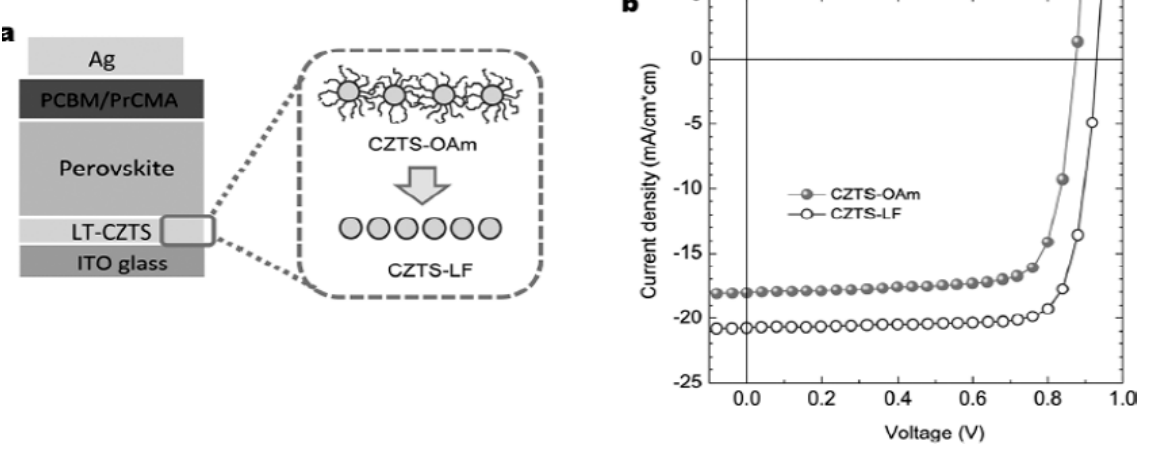
Fig. 6. Structure and performance of device (ITO/CZTS/CH Device structure (b) J-V curve of the champion device, reprinted with permission from L.S. Khanzada,